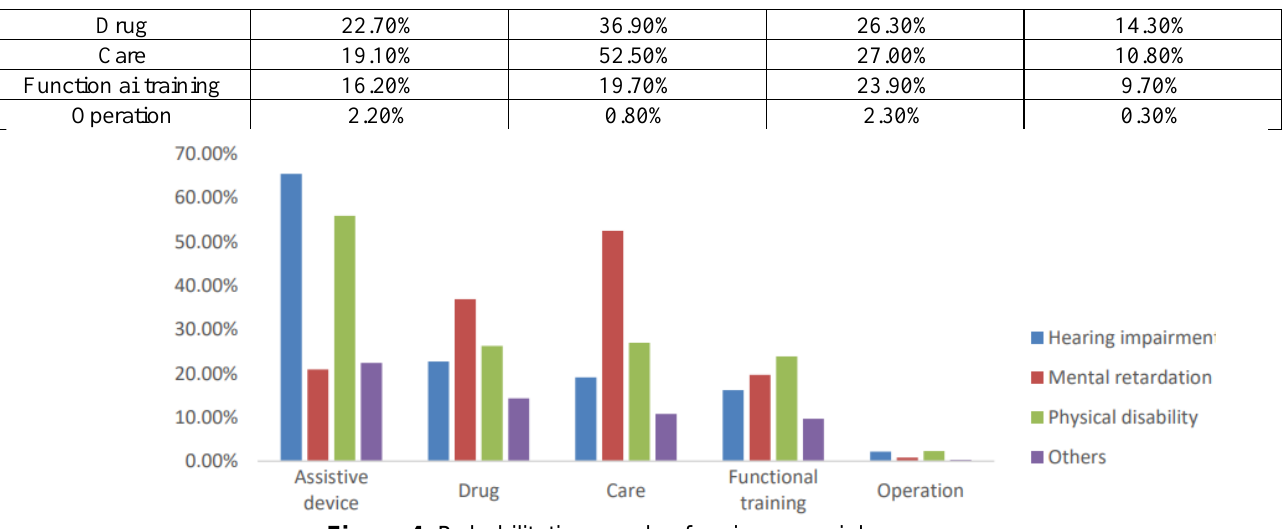
Figure 4. Rehabilitation needs of various special